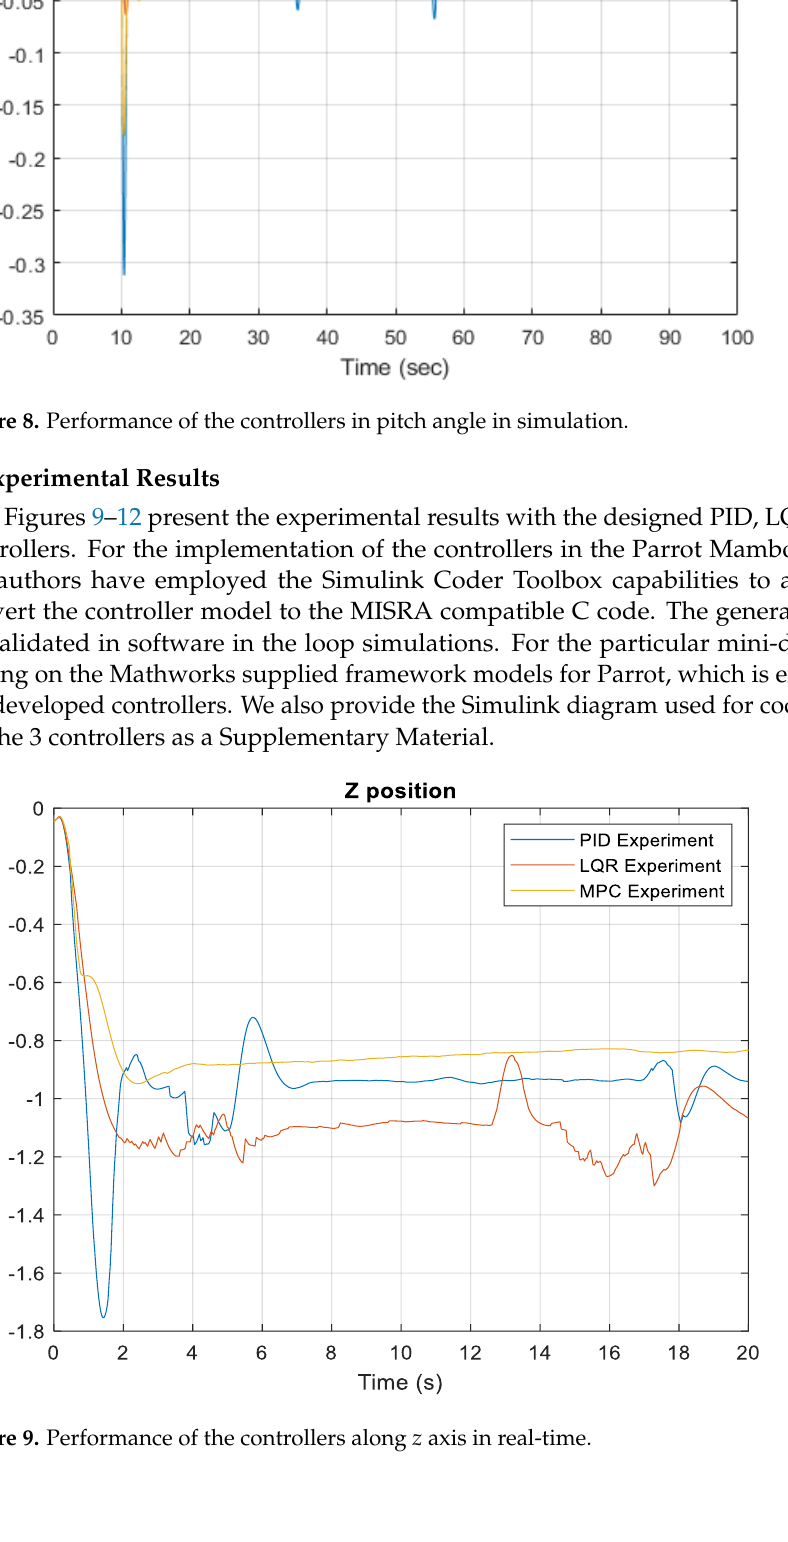
Figure 10. Performance of the controllers for yaw angle in real-time. The controllers do not show the same response in their rotational motion as they show in simulation. PID controller shows significant overshoot in the pitch angle response and undershoots in yaw angle response. However, PID response is better compared to LQR and MPC in yaw movement. Along both roll and pitch movement, MPC and LQR show jittery responses, while PID is better in response compared to them. This work introduces the simulated and experimental results of the Parrot mini- drone flight with three different controllers such as MPC, PID, and LQR. This study com- pares the performance of the controllers from several aspects such as tracking error, sta- bility, and robustness. From the tracking error aspect in simulation, LQR performs well compared to PID and MPC. However, in terms of stability and robustness in real-time, MPC shows promising performance while both PID and LQR show fluctuations in their responses. Theoretically, MPC should perform well because it is a nonlinear controller